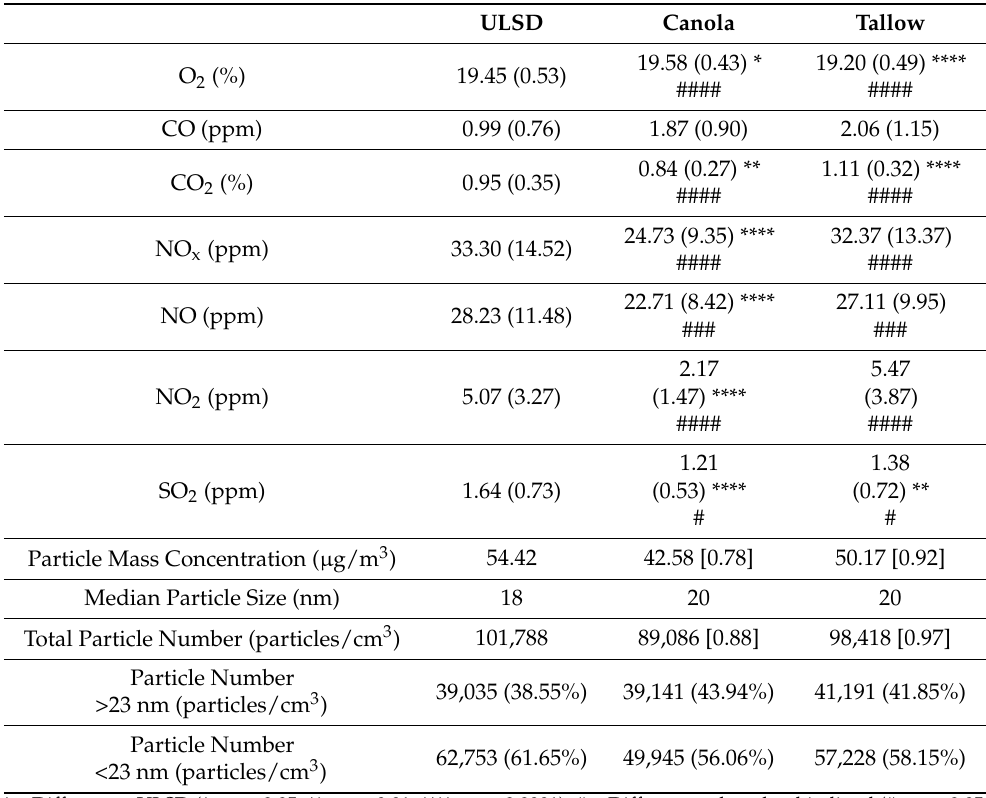
Table 1. Mean (standard deviation) combustion gas concentrations and mean particle characteristics representative of what each group of mice were exposed to for the three measured exhausts. Mea- surements are shown as the mean concentrations for all of the exposures, with the exception of CO, which is shown as the mean peak measurement. Data in square brackets are ratios in comparison to ULSD, particle data in parentheses are percentages of the total within the fuel. Data were analyzed using general additive modeling methodologies. ULSD